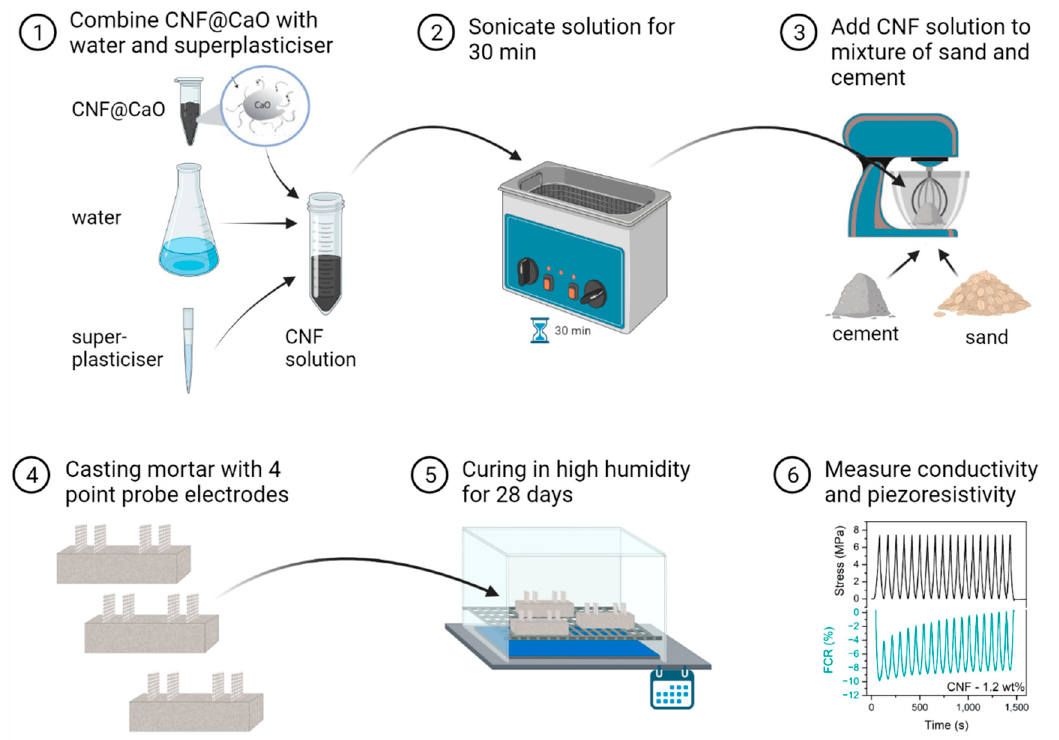
Figure 2. Workflow used for dispersion of CNF in mortar, followed by measurement of electrical properties.